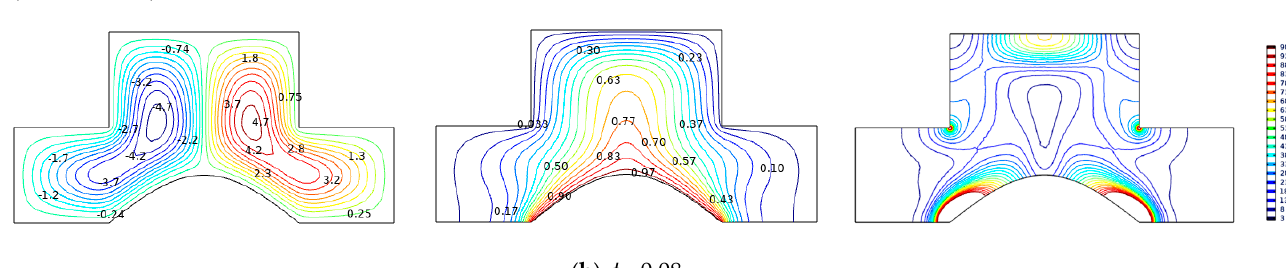
Figure 14. Average Nusselt number (Nu ave ) as a function of solid volume fraction ( φ ) at various values of porosity ε p . Ra = 10 6 , Ha = 0, and Da = 0.01.